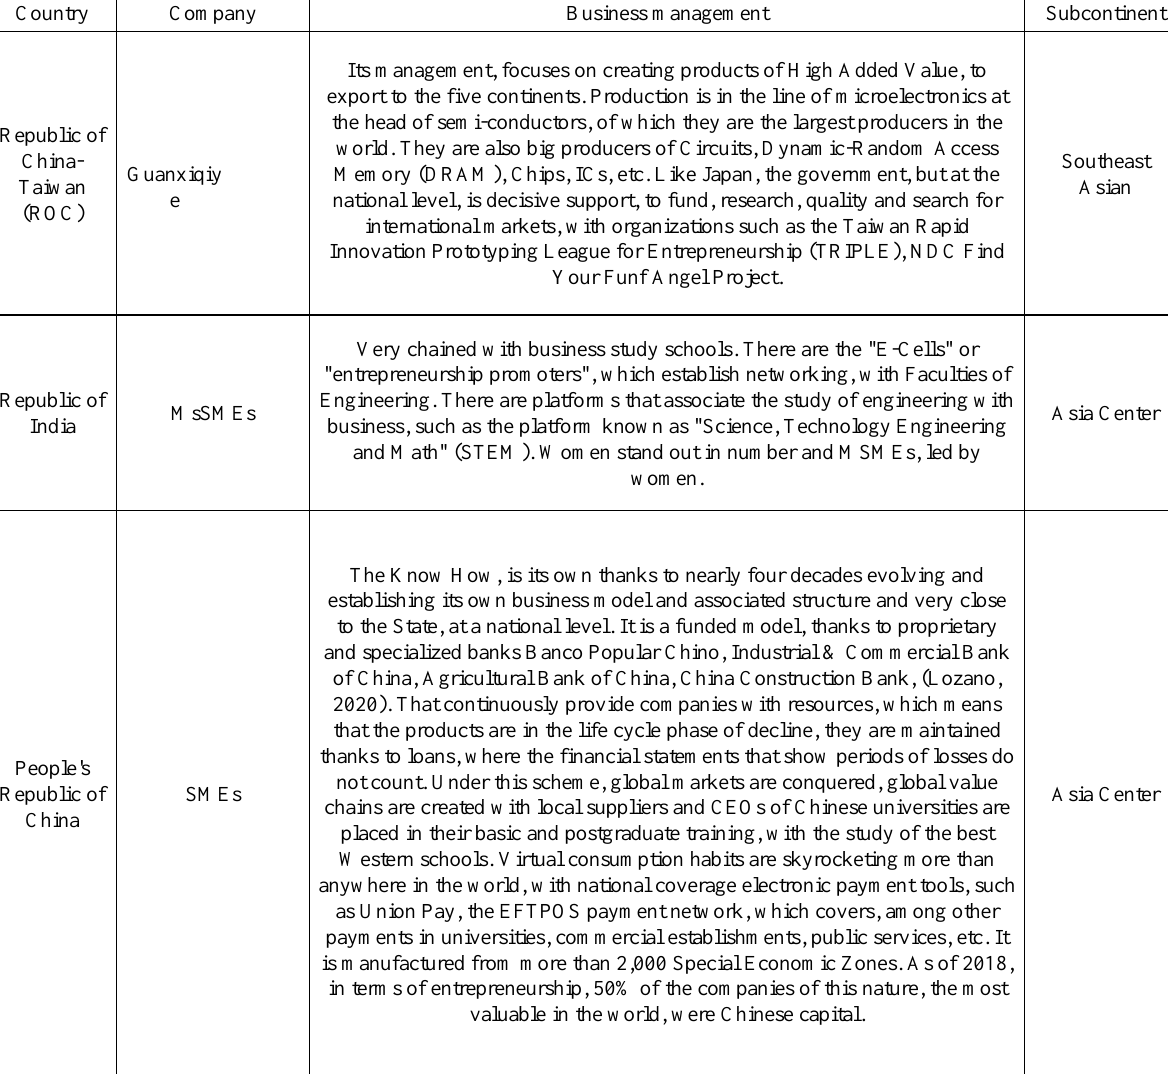
Table 1 (cont.). Characteristics of pre-pandemic business and entrepreneurship